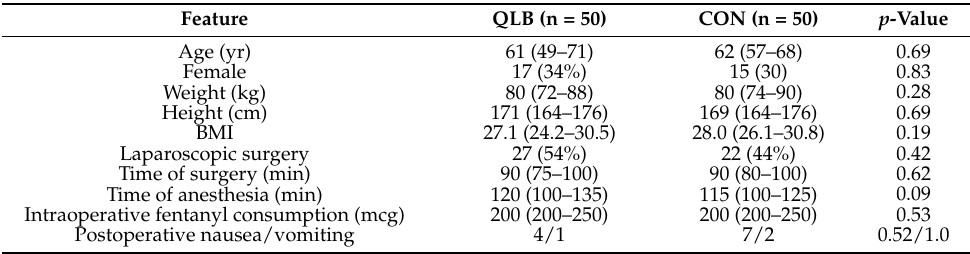
Figure 1. Study flowchart; CON: control group; QLB: quadratus lumborum block group. Table 1. Patient demographics and surgery